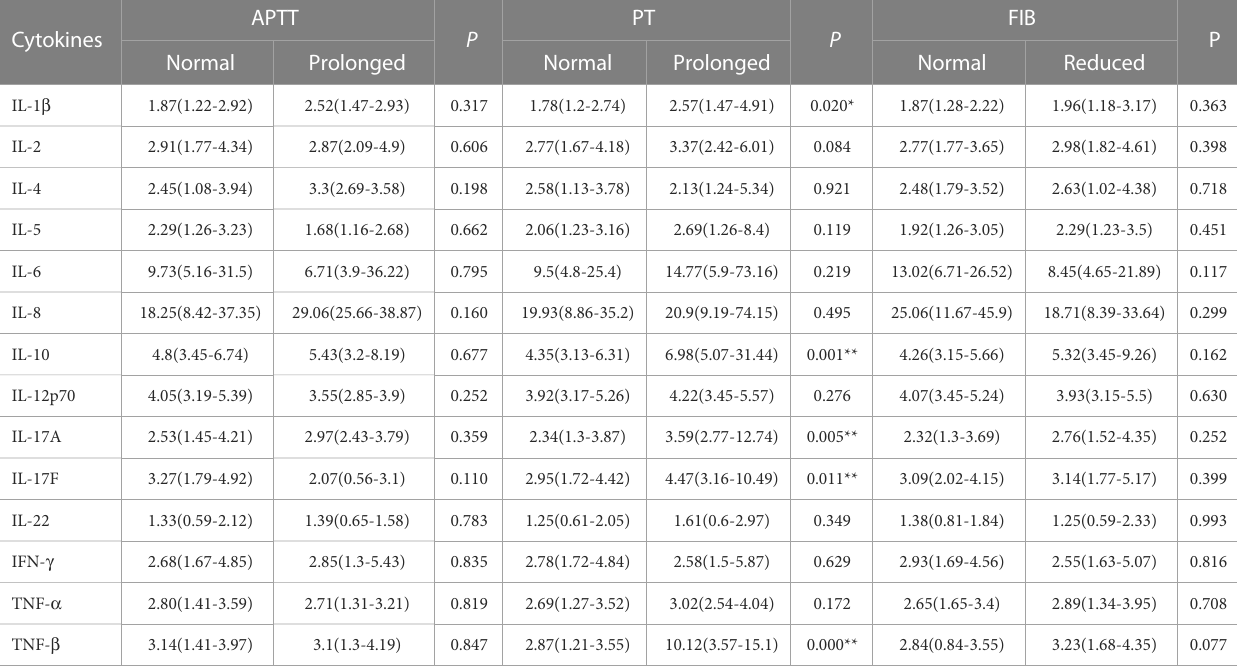
TABLE 4 Impact of cytokine levels on blood coagulation in newly diagnosed APL patients (pg/ml, M[IQR]).